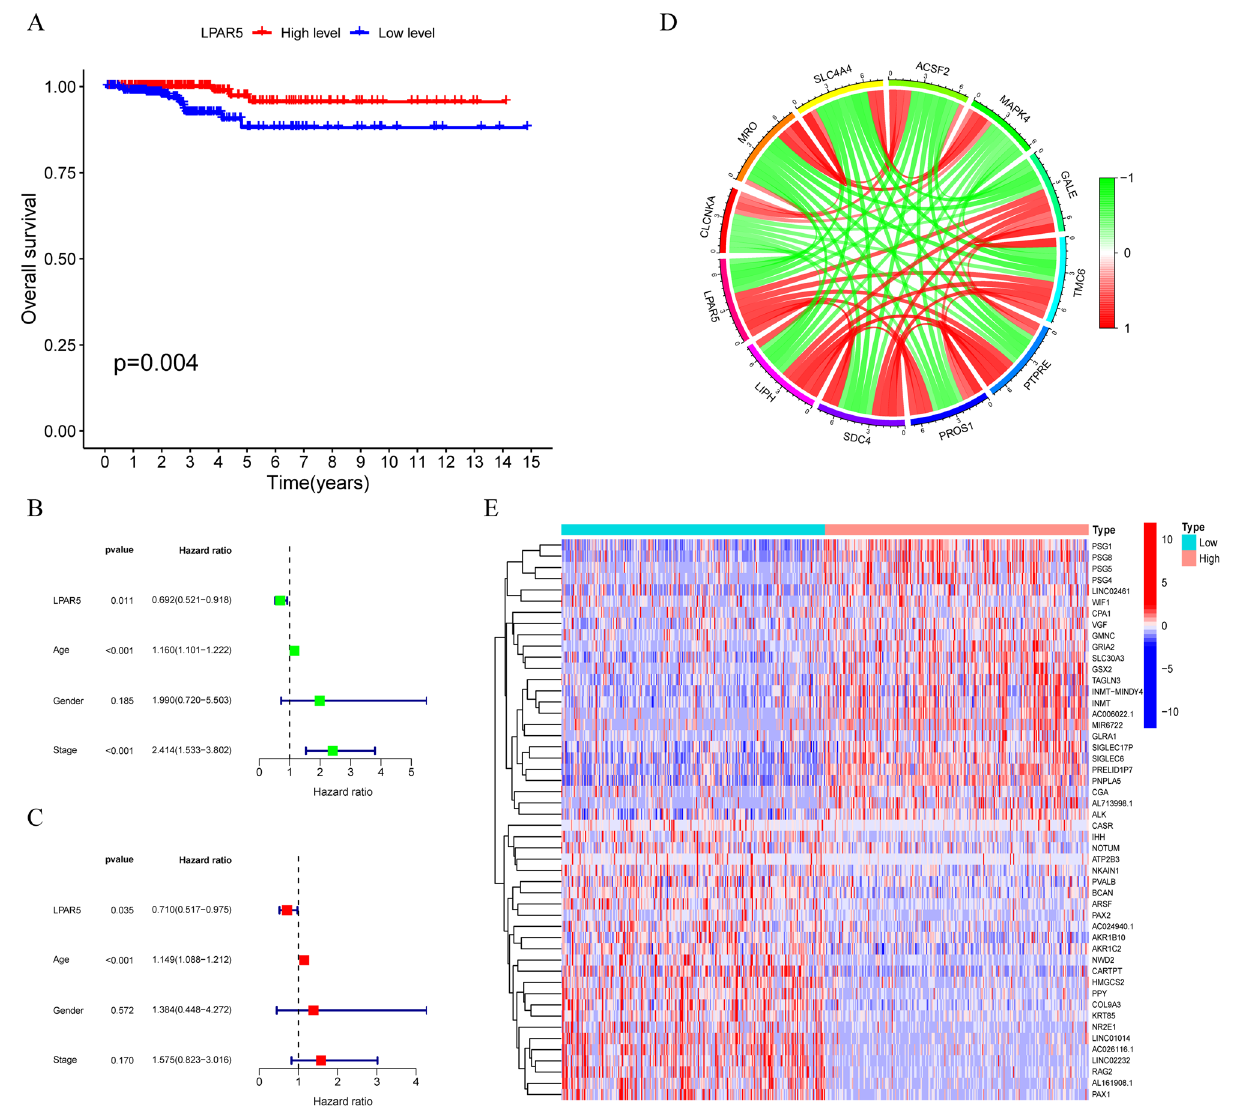
Figure 2. Survival analysis, univariate and multivariate Cox regression analyses, co-expressed analysis of LPAR5 in PTC, and expression of differentially expressed human genes in LPAR5 high and low expression samples. ( A ) LPAR5 is related to the survival time of patients, and with the increase of LPAR5 expression, the prognosis of PTC patients was better. ( B , C ) Uni-Cox and multi-Cox regression analyses showed that both age and expression of LPAR5 were independent risk factors for survival in PTC patients. ( D ) The six genes with the strongest positive correlation and the five genes with the strongest negative correlation with LPAR5. ( E ) The 25 most significantly up-regulated DEGs and 25 most significantly down-regulated DEGs in both high and low expression groups of LPAR5. [Figures created by R, version co-expressed genes of LPAR5 were analyzed, and a total of 65 genes with co-expression relationships to LPAR5 were obtained, of which 13 genes were negatively correlated and 52 genes were positively correlated. All results are shown in Additional file P1 (|cor| > 0.7, p-value < 0.001). We also visualized the six genes with the largest correlation coefficient and the five genes with the smallest correlation coefficient (Fig. 2D); the red and green lines represent positive and negative correlations, respectively. After analyzing the differences in genes between the two groups with high and low LPAR5 expression, we obtained 1566 differentially expressed genes (DEGs) (|Log 2 FC| > 1, FDR < 0.05, and p-value < 0.05). A total of 299 genes were highly expressed in the LPAR5 high expression group and 1267 genes were highly expressed in the LPAR5 low expression group, and the top 25 DEGs in the two groups with high or low expression of LPAR5 were selected to create a heat map (Fig. 2E). Gene ontology, Kyoto encyclopedia of genes and genomes, and mutation frequency of tumor gene.